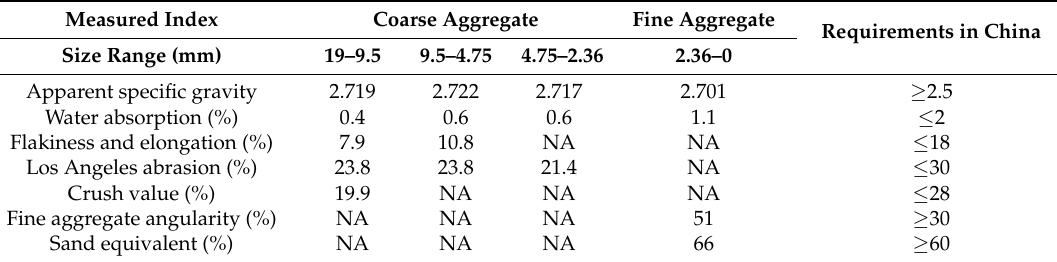
Table 2. Basic technical properties of granite aggregates.